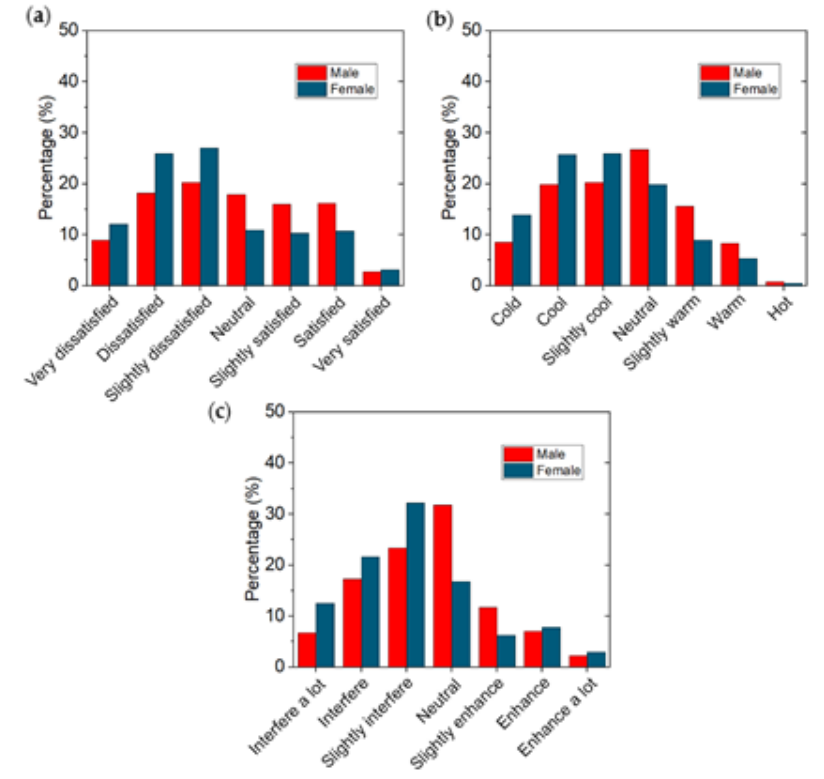
Figure 5. Distribution of responses obtained for ( a ) TSaV; ( b ) TSV; ( c ) TIP.